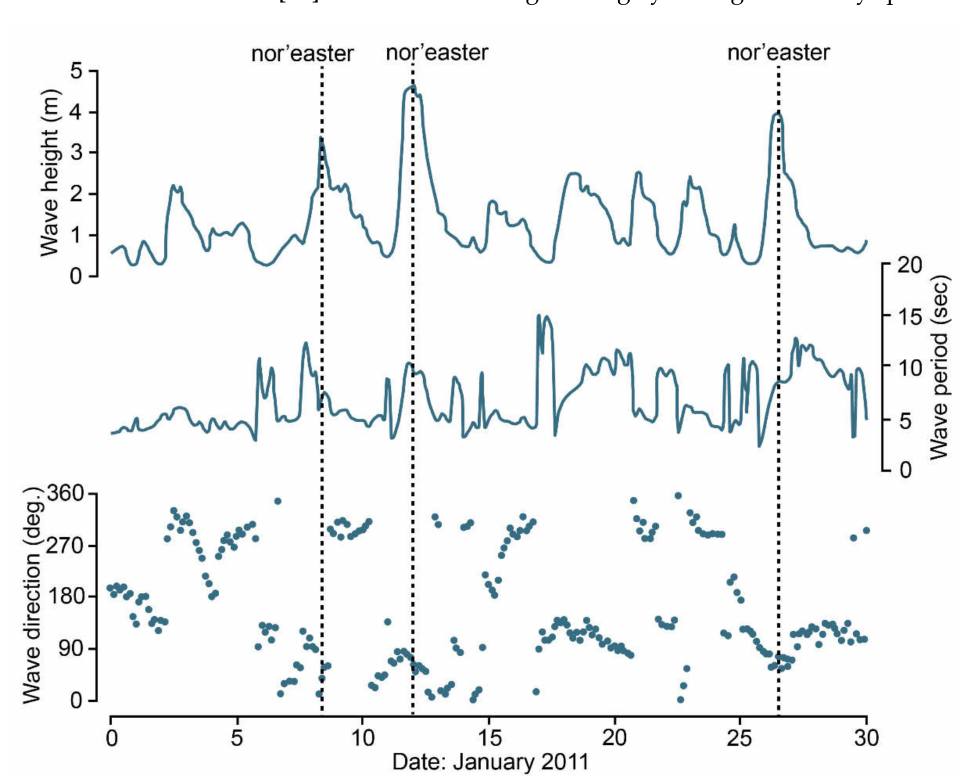
Figure 2. Significant wave data collected at NDBC buoy 44098 located 50 km east of Merrimack River Inlet. Data from Li et al. [53]. Note the largest waves were recorded from the northeasterly quadrant.